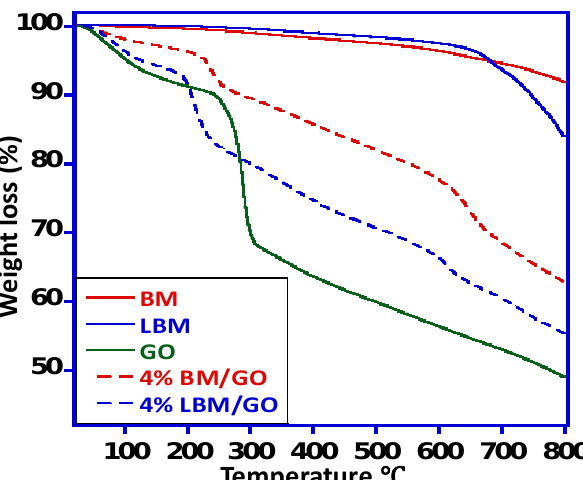
Figure 1. Comparative thermal degradation patterns of Bi 2 MoO 6 (BM), La-Bi 2 MoO 6 (LBM), graphene oxide (GO), 4% BM/GO, and 4% LBM/GO.